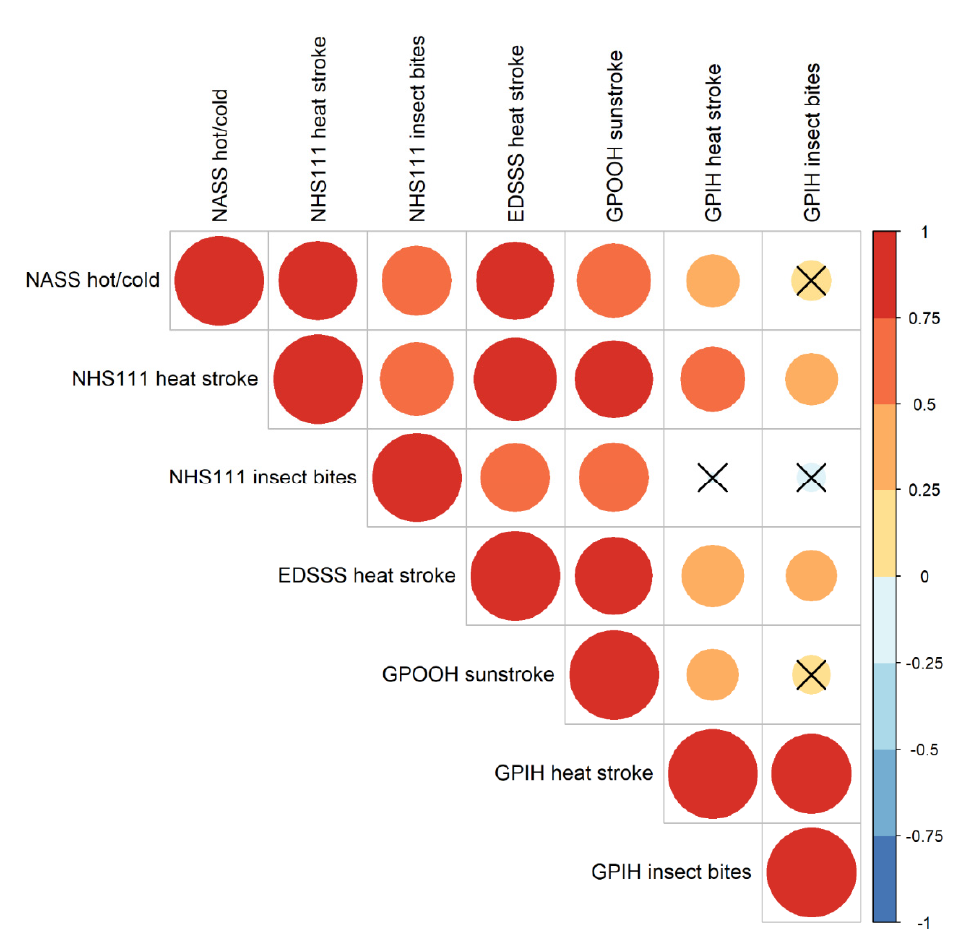
Figure 3. Correlation between NASS heat/cold exposure CPC calls and related syndromic indicators from telehealth (NHS 111), emergency department (EDSSS), GP in hours (GPIH), and GP out of hours’ (GPOOH) systems. Each circle represents a correlation pair (small circles represent a weak and large a strong correlation, respectively), with the color and size dependent on the pairs correlation co-efficient (r). Circles without crosses represent significant correlations and circles with crosses signify non-significant correlation between indicators.